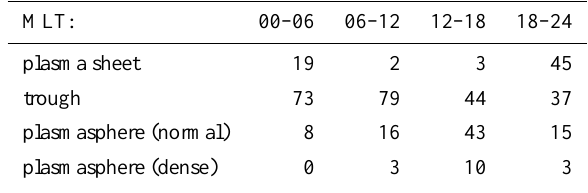
Table 1c. As Table 1a, but for K p = 3 −